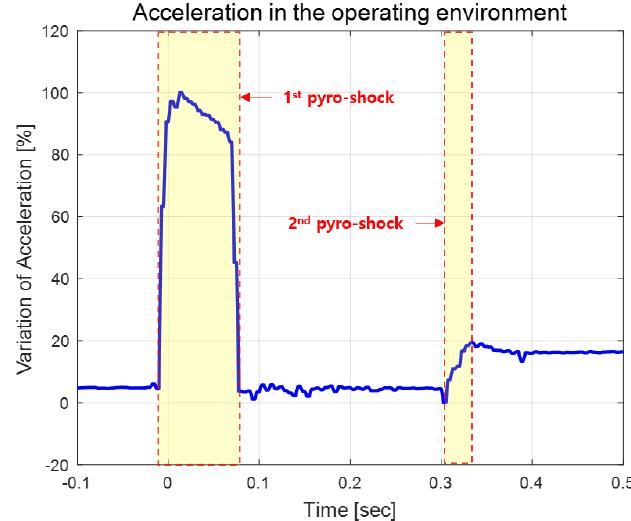
Figure 5. Acceleration profile in actual operating environment.